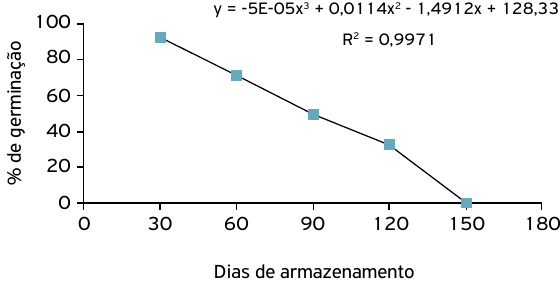
Figura 3. Porcentagem de germinação de conídios de B. bassiana em mistura granulada acondicionada em embalagem de poliéster metalizado armazenada em câmara climatizada (temperatura 25 ± 1°C) durante 150 dias.